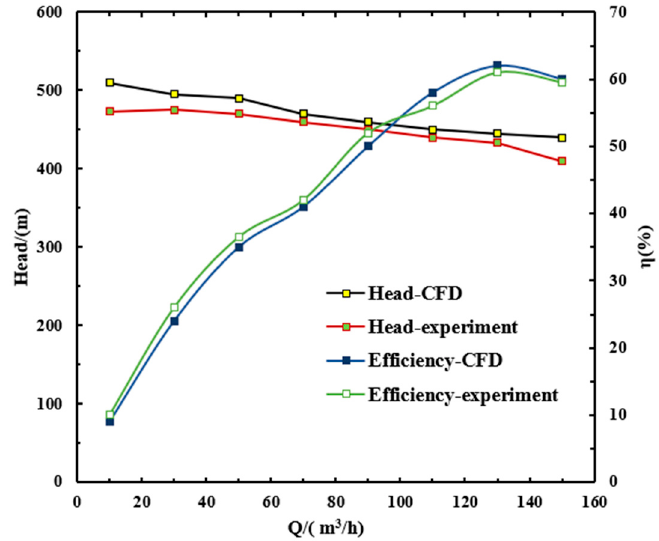
Figure 4. Pump performance curves at different flow rates.